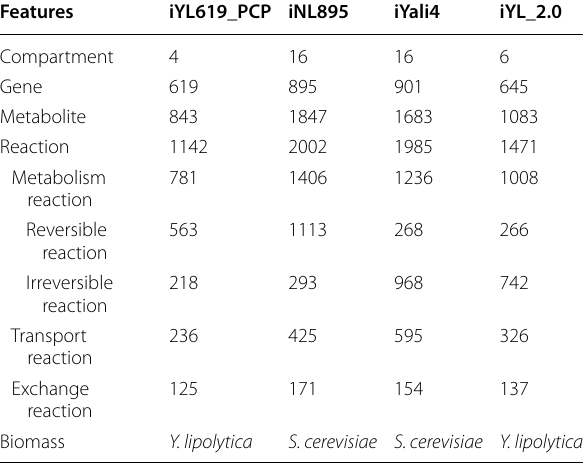
Table 1 Features of four genome-scale metabolic